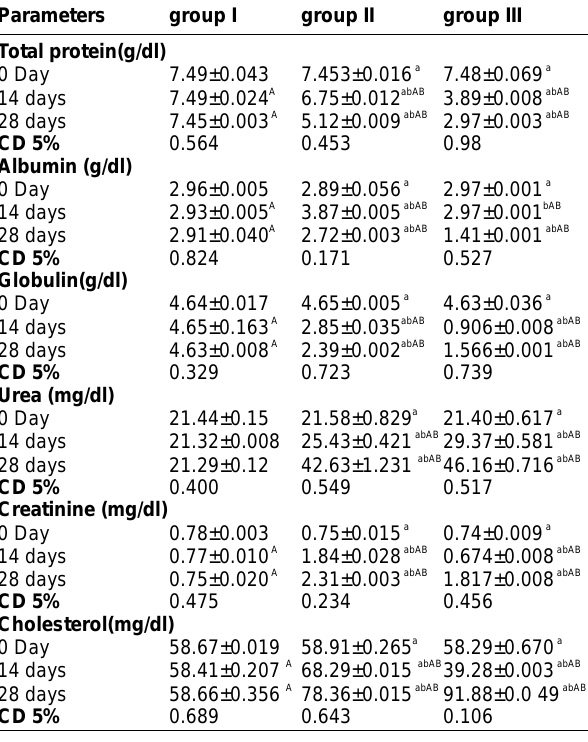
Table-3. Effect on biochemical parameters following daily oral administration of Jatropha seed oil with our without treatment for 28 days in goats (mean ± S.E., N=3 per